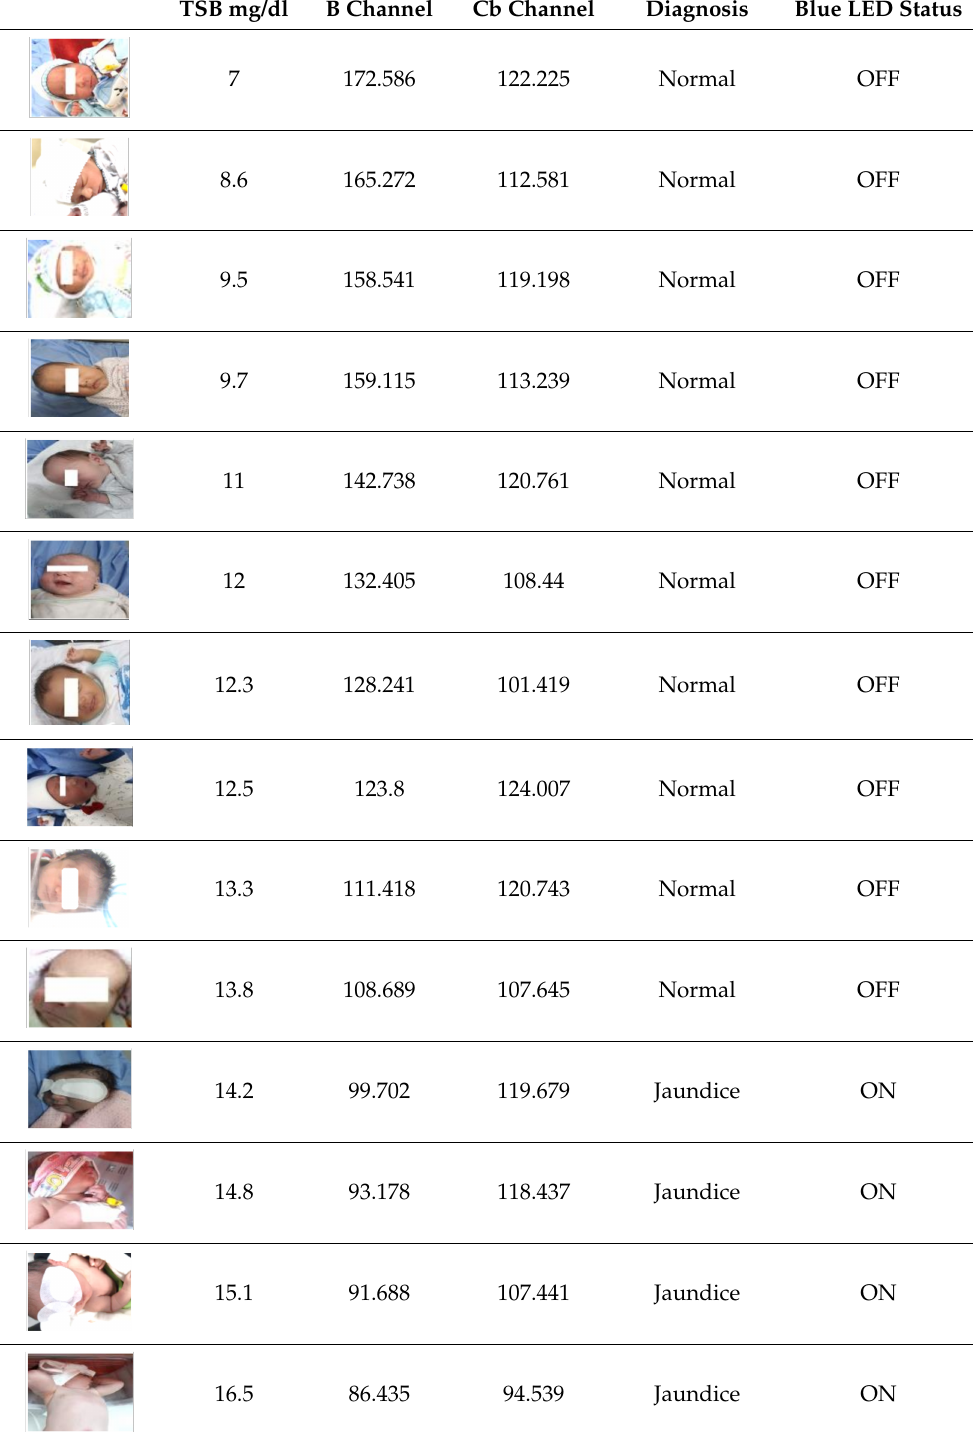
Table 3. A comparison between the TSB and diagnosis results of the proposed